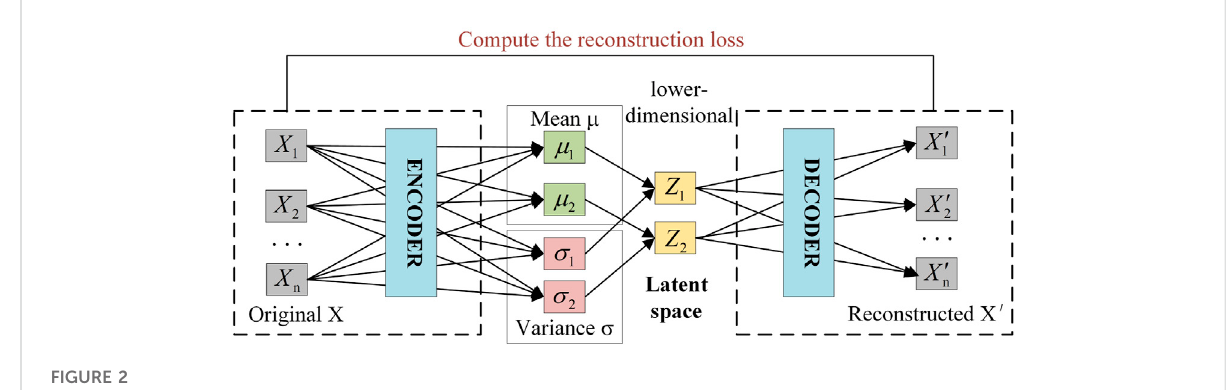
FIGURE 2 The structure of the VAE